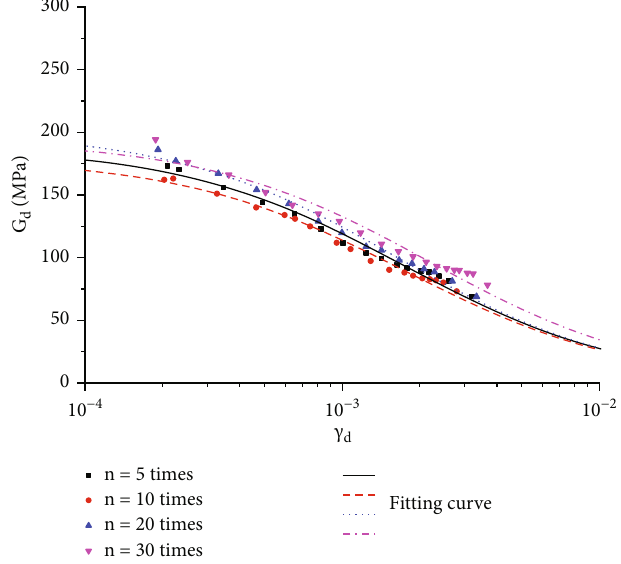
Figure 15: Dynamic shear modulus-strain curves at di ff erent freeze-thaw cycles (-15 °